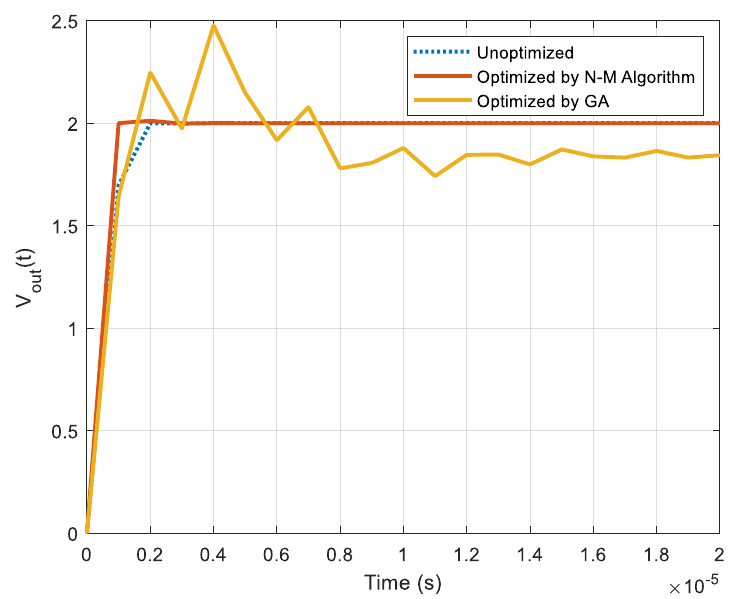
Figure 6. Output voltage response offered by digital compensators.